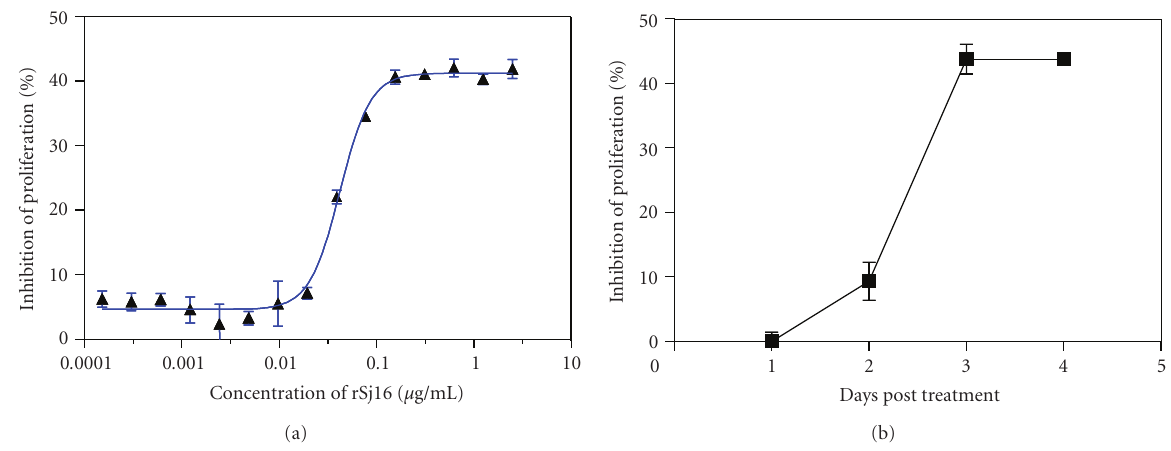
Figure 1: Antiproliferative e ff ect of rSj16 on WEHI-3B JCS cells . WEHI-3B JCS cells were incubated with 0.2 ml of medium containing di ff erent doses of rSj16 for 72 hours (a) or containing 0.5 μ g/ml of rSj16 for up to 96 hours (b). The proliferation was quantified by MTT